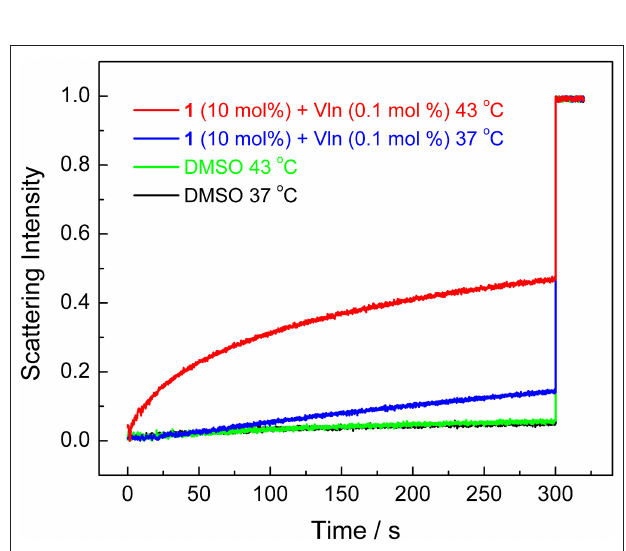
FIGURE 6 | Normalized KF efflux quantified by lipids composed of DPPC under 37 and 43 ◦ C in the osmotic assay.